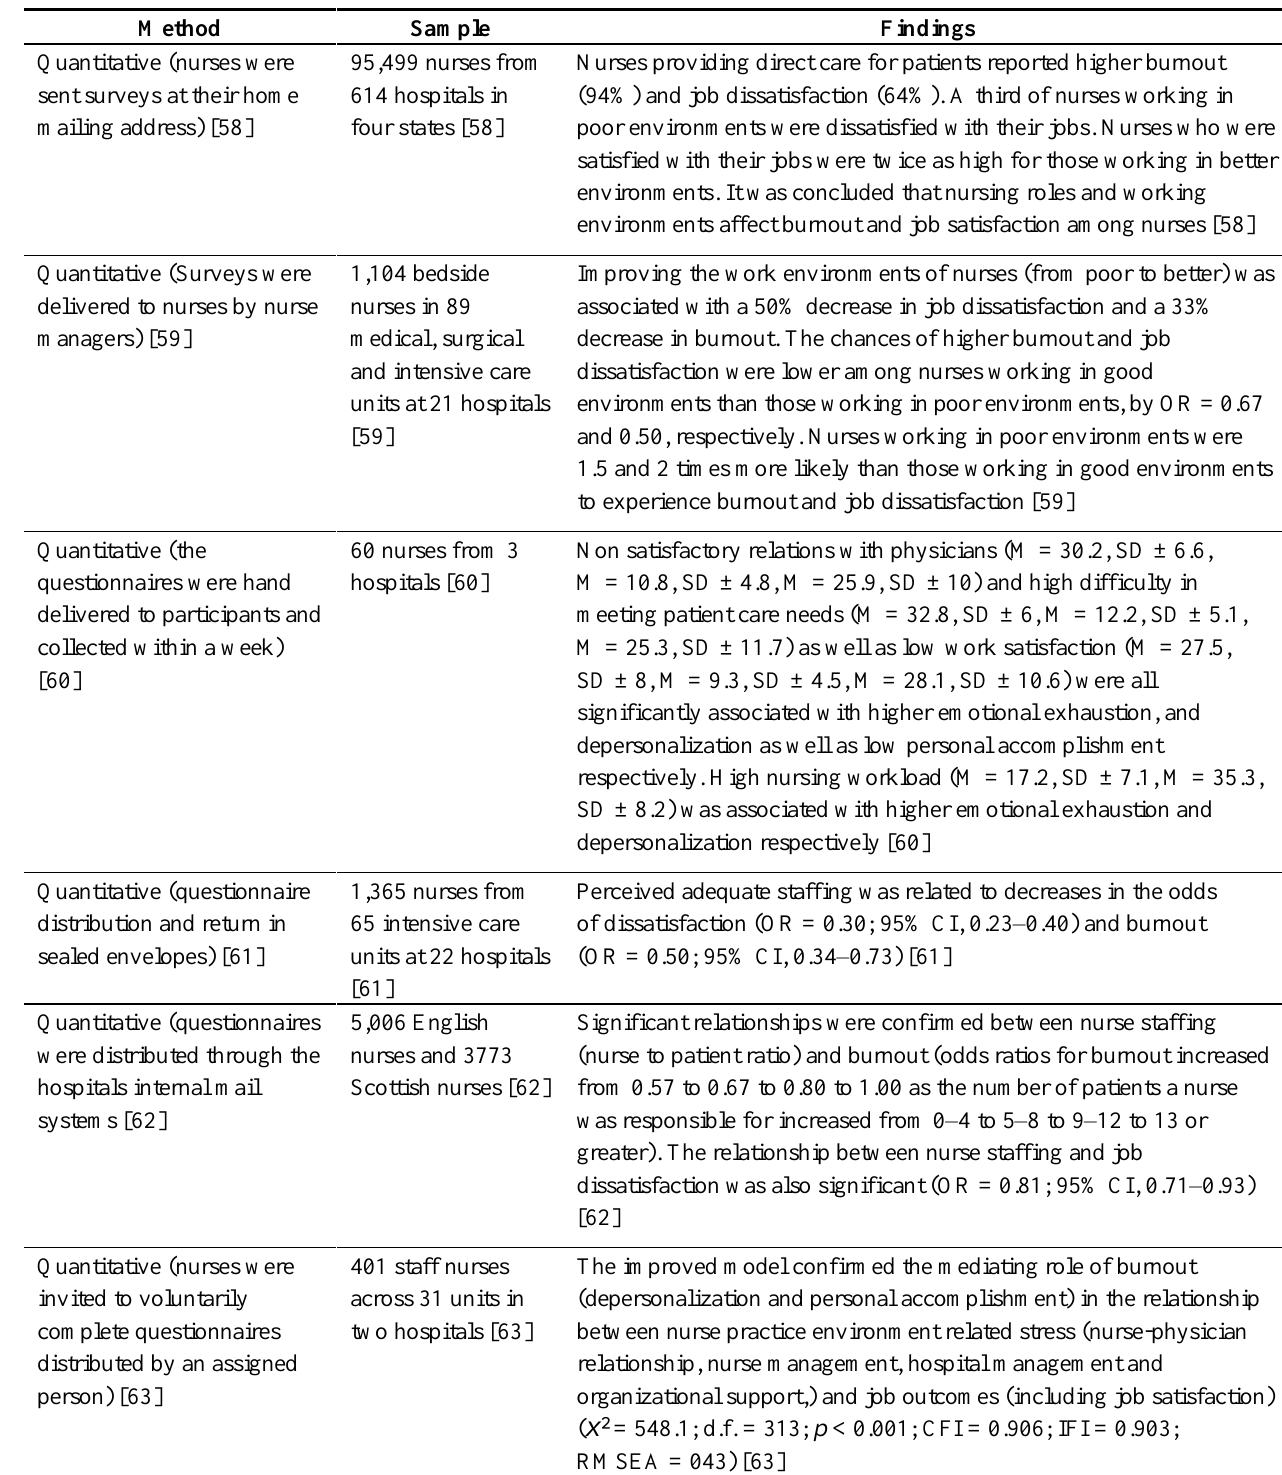
Table 4. Method, sample and findings of identified